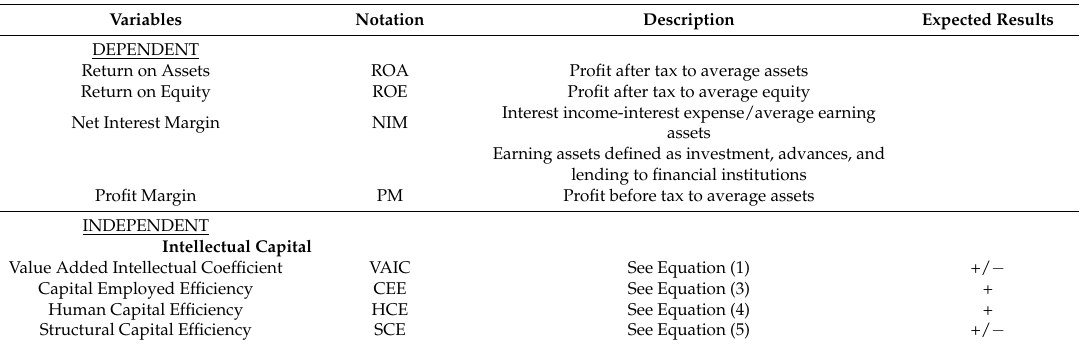
Table 2. List of